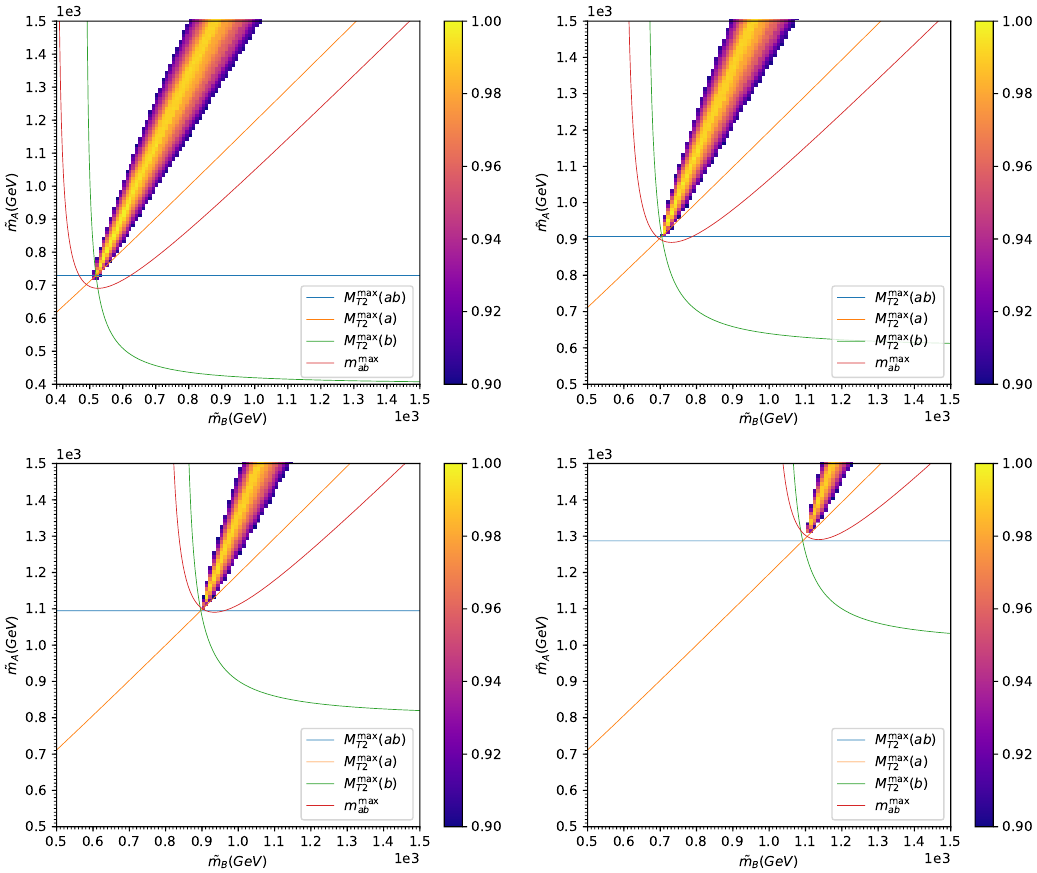
Figure 11 . The same as (cid:12)gure 8, but for di(cid:11)erent values of ~ m m = 700 GeV. The top two plots have ~ m C (top right). The bottom two plots correspond to ~ m ~ m = 1000 GeV (bottom right). Note that for ~ m C M max ( ab ) constraint) which misses the region of high T 2